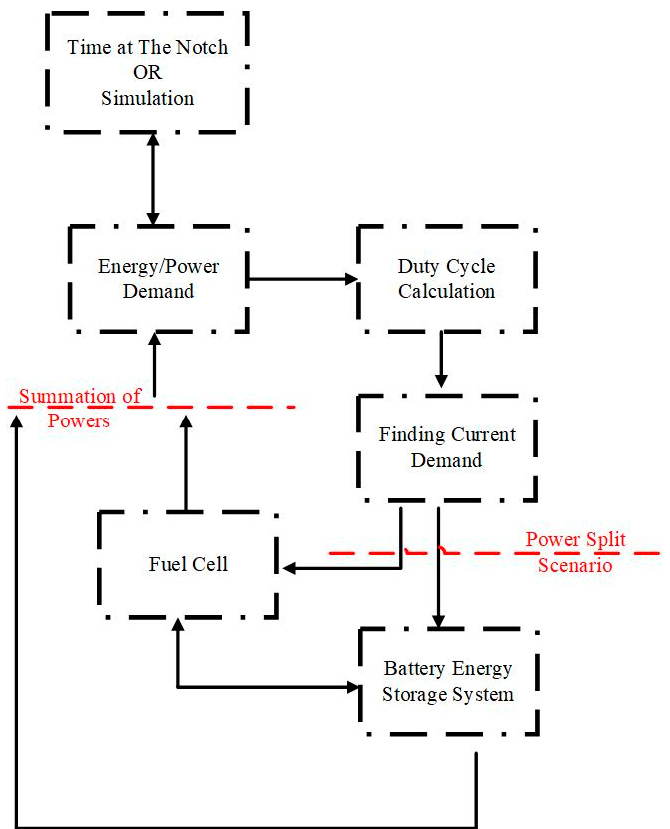
Table 2. Modified preliminary prime mover and final drive specifications.